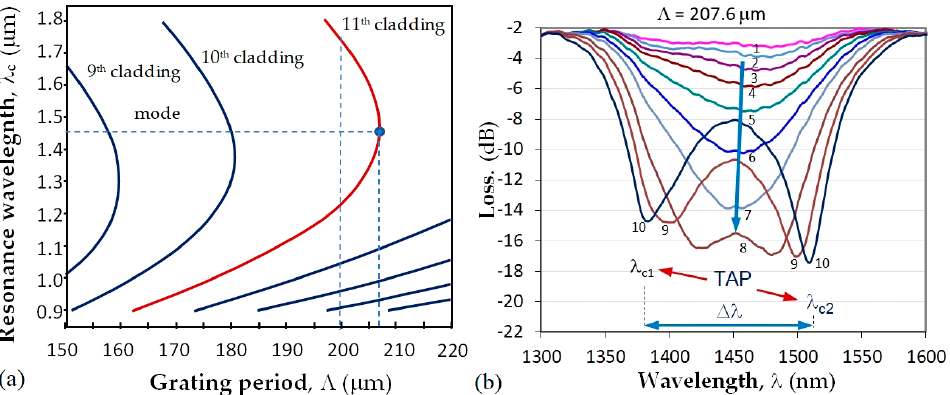
Figure 2. LLPG around turning point: ( a ) dispersion dependence and TAPs of photosensitive fiber PS1250/1500 (Fibercore) for different cladding modes; ( b ) TAP LPG splitting and transformation into a double resonance grating for the 11th cladding